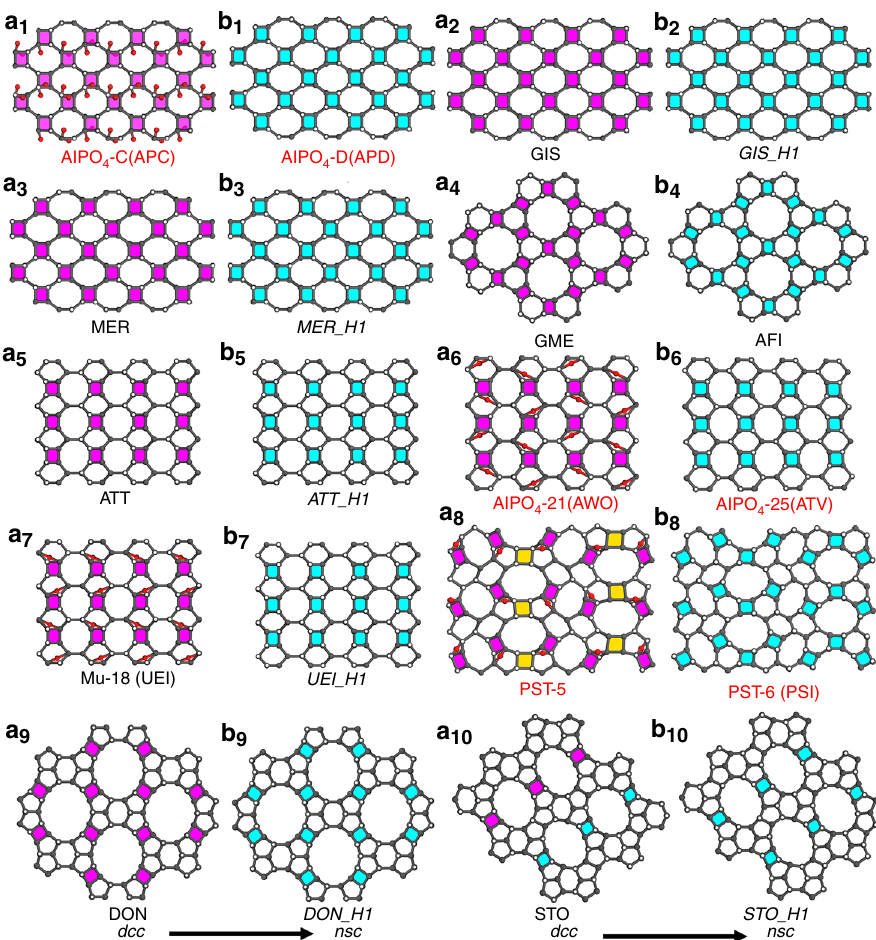
Fig. 4 Illustration of observed and predicted 3D – 3D topotactic transformations. a 1 – a 10 Projections of the APC, GIS, MER, GME, ATT, AWO, UEI, PST- 5, DON, and STO frameworks. All of them contain double-crankshaft chain ( dcc ). Among them, APC, AWO, UEI, and PST-5 contain penta- or hexa- coordinated atoms. b 1 , b 6 , and b 8 Projections of APD, ATV, and PSI (PST-6) frameworks after topotactic transformation by changing dcc to narsarsukite chain ( nsc ). They have the same framework projections as APC, AWO, and PST-5, respectively, but differ in the 3D connectivity along the projections. b 2 – b 5 , b 7 , b 9 , and b 10 Selected hypothetical structures of GIS_H1 , MER_H1 , ATT_H1 , UEI_H1 , DON_H1 , and STO_H1 generated by replacing dcc with nsc . Magenta: dcc ; cyan: nsc ; yellow: double four-ring ( d 4 r ). The solid and hollow circles indicate vertices that connect upwards and downwards,